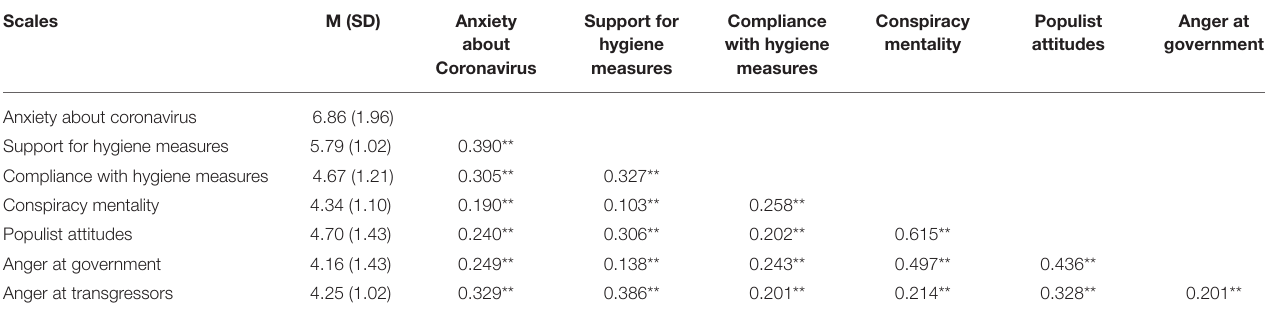
TABLE 3 | Pearson correlations between scales. Scales M